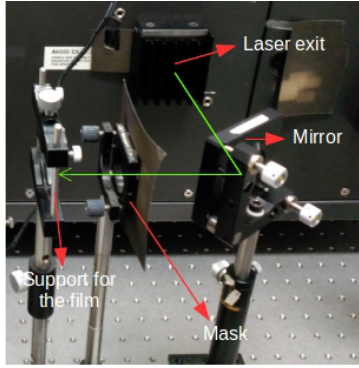
Figure 1. Experimental apparatus for the laser annealing process. The laser path is shown in